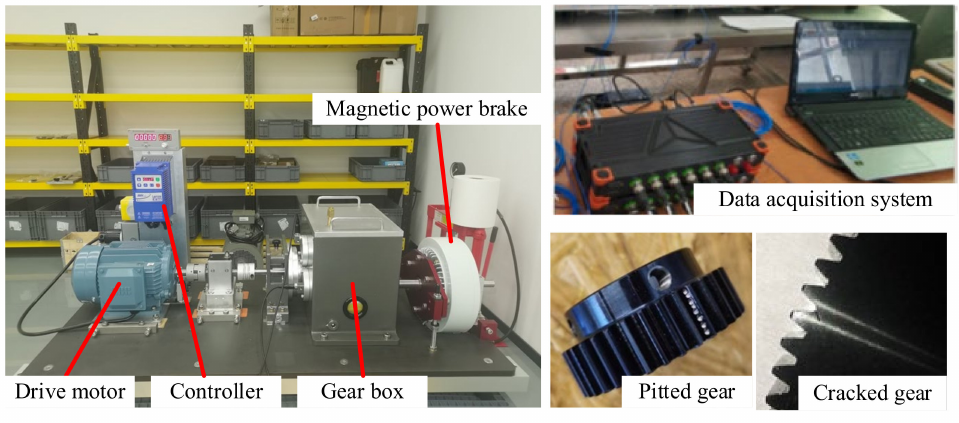
Figure 24. Test bench and faulty